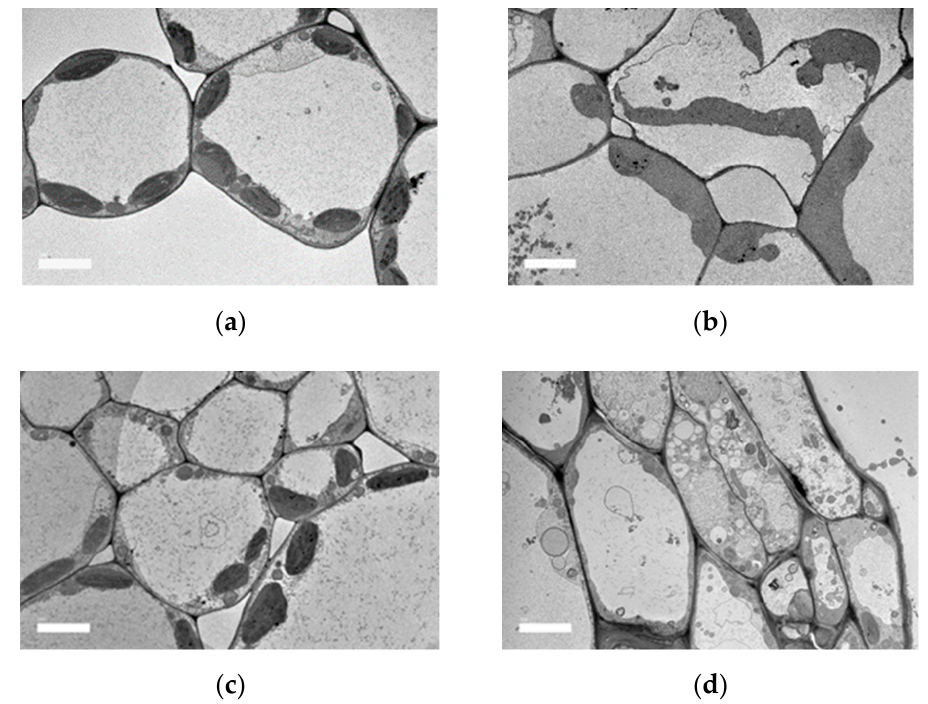
Figure 5. Transmission electron microscopy (TEM) analysis of leaf tissues from pennywort leaves control day 0 ( a ), day 12 ( b ) and AEW with PL 1.5 day 0 ( c ) and day 12 ( d ).